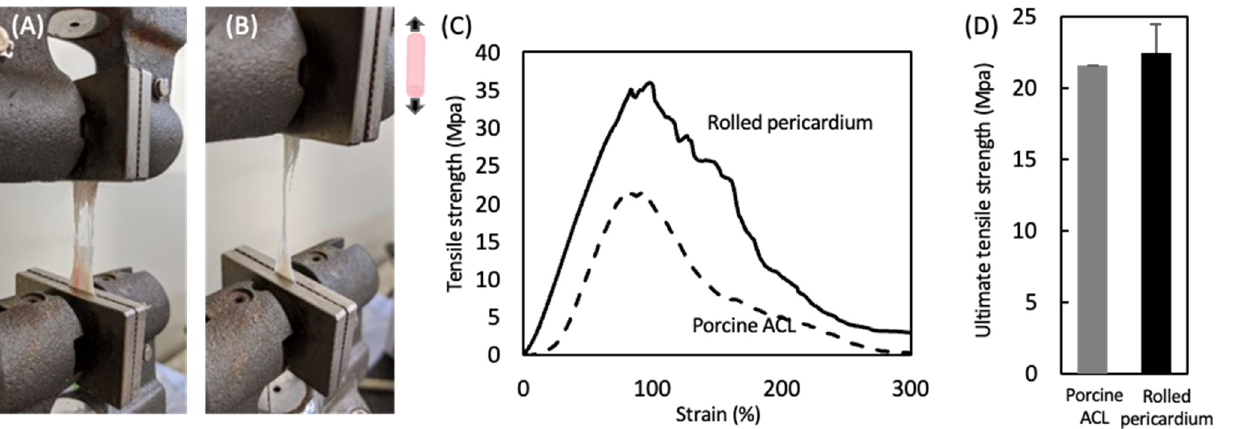
Figure 5. Photographs of the ( A ) porcine ACL and ( B ) rolled pericardium decellularized with the HHP method during a tensile test. Mechanical properties of the porcine ACL and rolled pericardium decellularized with the HHP method: ( C ) typical S–S curves and ( D ) ultimate tensile strength. Mean ± standard deviation, n = 6; no significant differences were identified between groups (one-way ANOVA, p < 0.05; Tukey’s post hoc comparison).